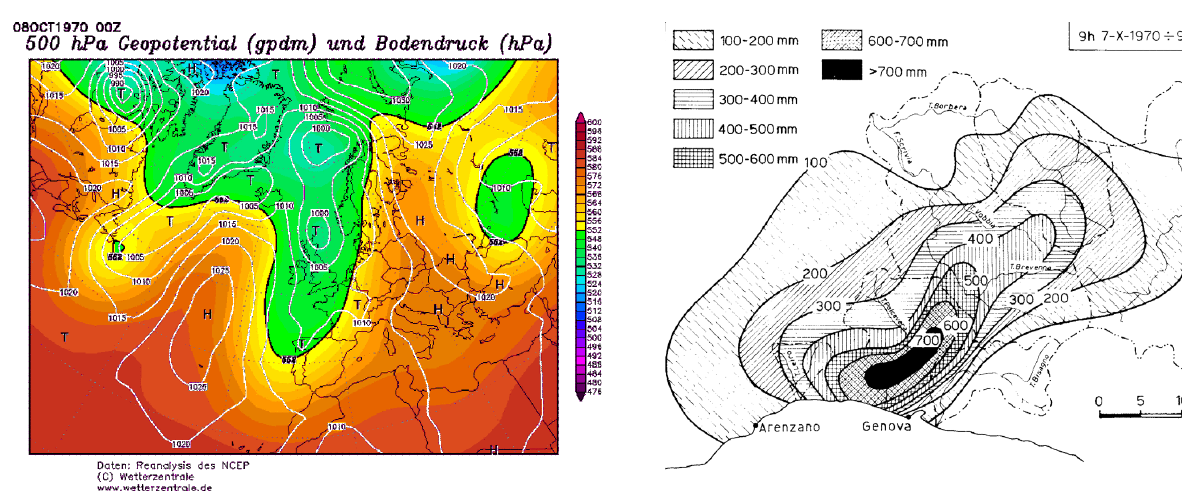
Fig. 4. The weather map on 8 October 1970, 00:00UTC shows the typical configuration of sea-level pressure (white contour lines) and the geopotential height at 500hPa (colored scale) fa- voring heavy rainfall and flooding in the Genoese area (from www.wetterzentrale.de).